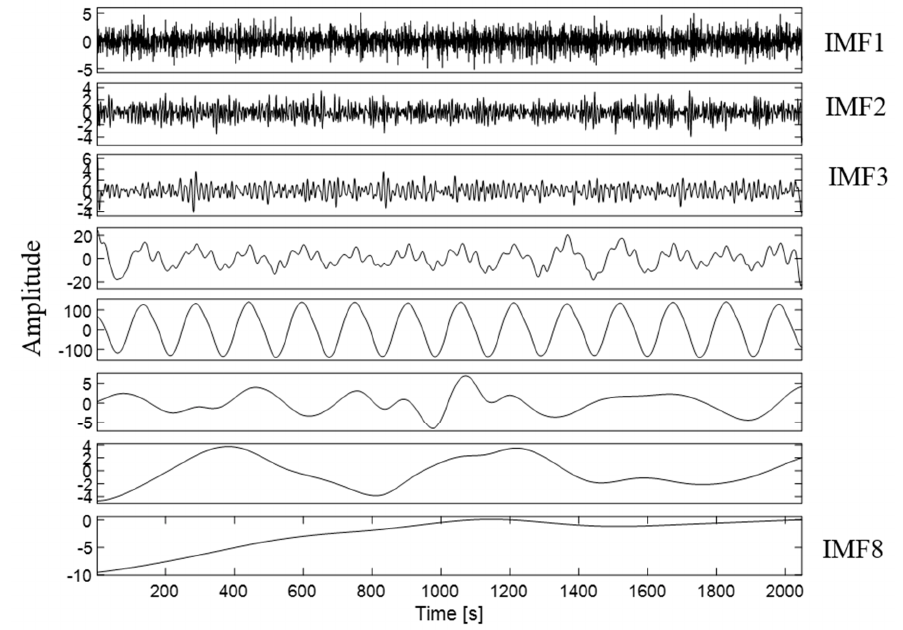
Figure 37. EEMD decomposition results of the original displacement signal.